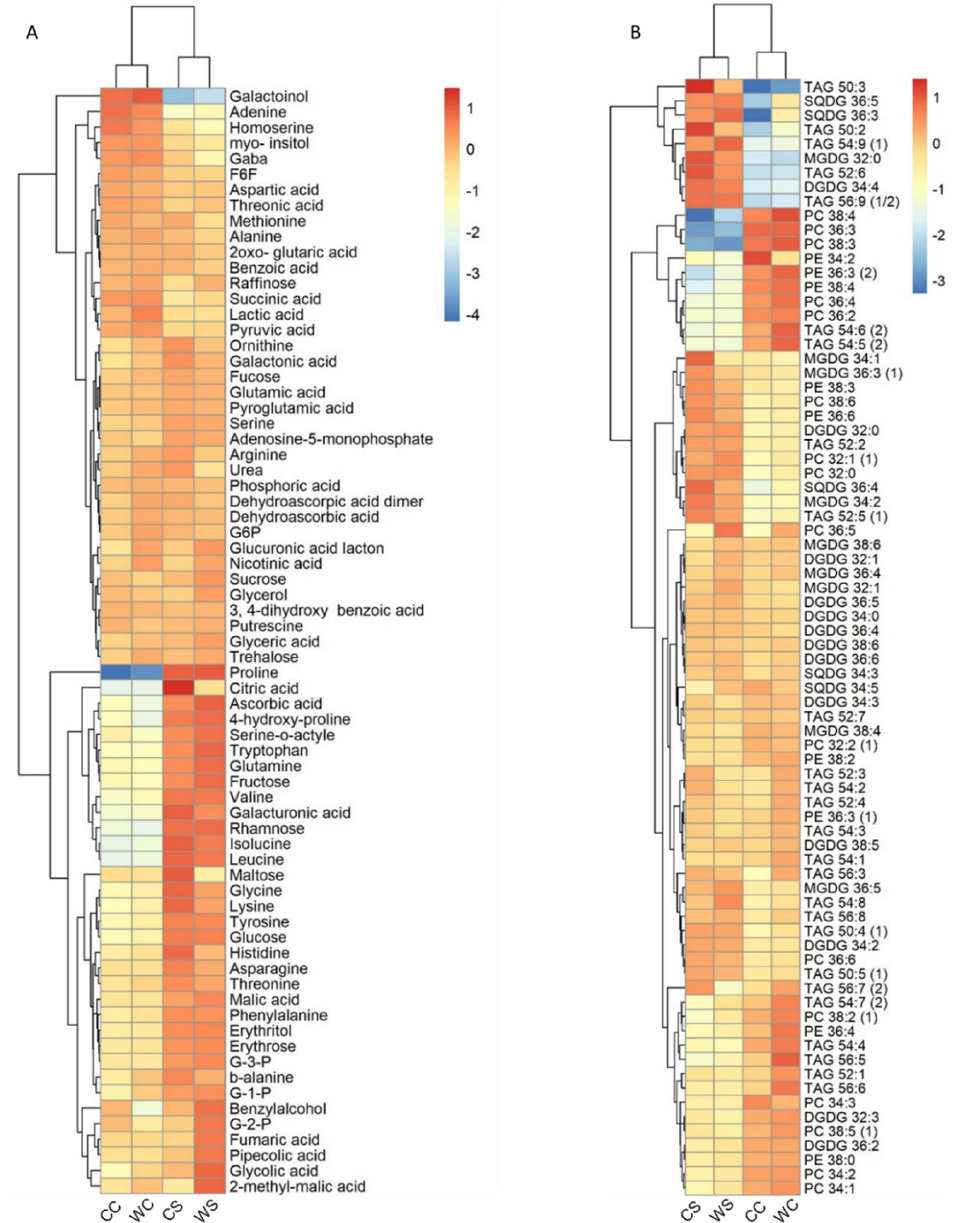
Figure 6. Heat map of primary metabolites measured by GC-MS ( A ) and lipids measured by UPLC-MS ( B ). Values correspond to log2 -fold changes in relation to control samples of the same genotype. Full data sets are provided in Table S1.